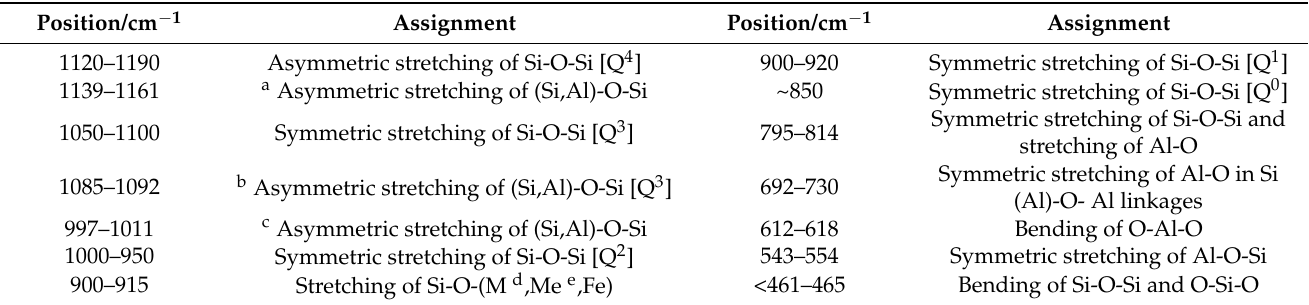
Table 4. Assignment of the deconvolved bands [48].